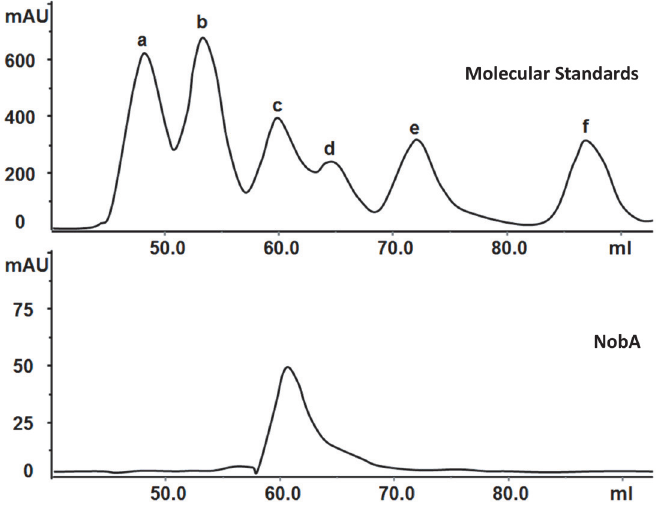
Figure 3. Determination of the native molecular mass of NobA by gel filtration chromatography. Standard proteins (a–f) used are the following: thyroglobulin (669 kDa), apoferritin (443 kDa), β -amylase (200 kDa), alcohol dehydrogenase (150 kDa), bovine serum albumin (66 kDa) and carbonic anhydrase (29 kDa). NobA has similar molecular weight to β -amylase (200 kDa) suggesting it naturally presence as a hexamer.